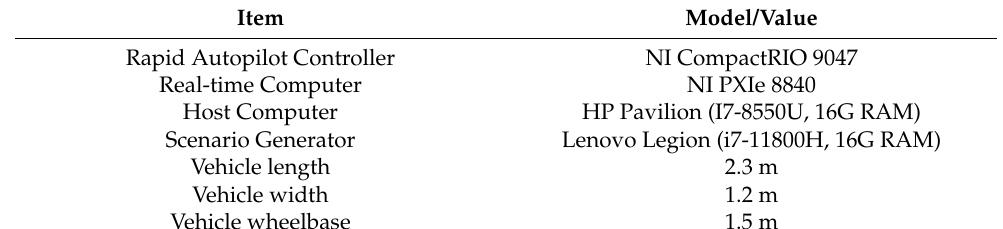
Figure 13. Rule-based speed profile generation.